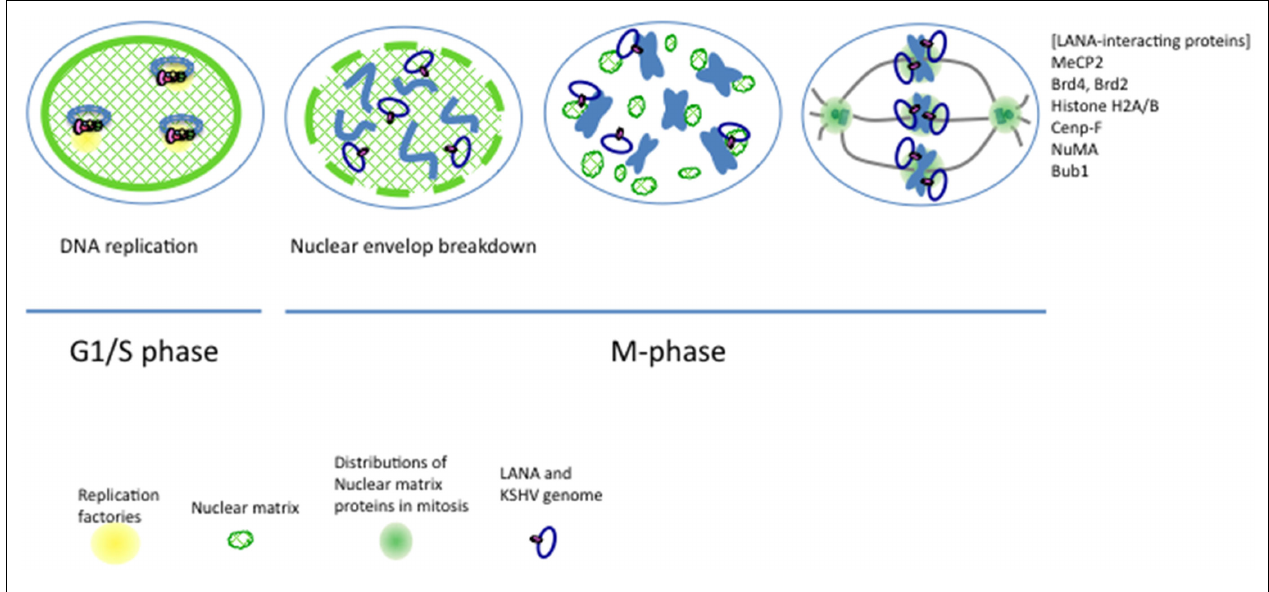
nuclear matrix proteins drastically change these functions and distributions; such as spindle pole or kinetochore proteins. It has been reported that KSHV LANA interacts with various proteins such as MeCP2, Brd2, Brd4, Histone H2A/B, Cenp-F, NuMA, Bub1, and so on.These interactions can associate a sister-chromatid with LANA, and thus KSHV genomes can separate into two daughter